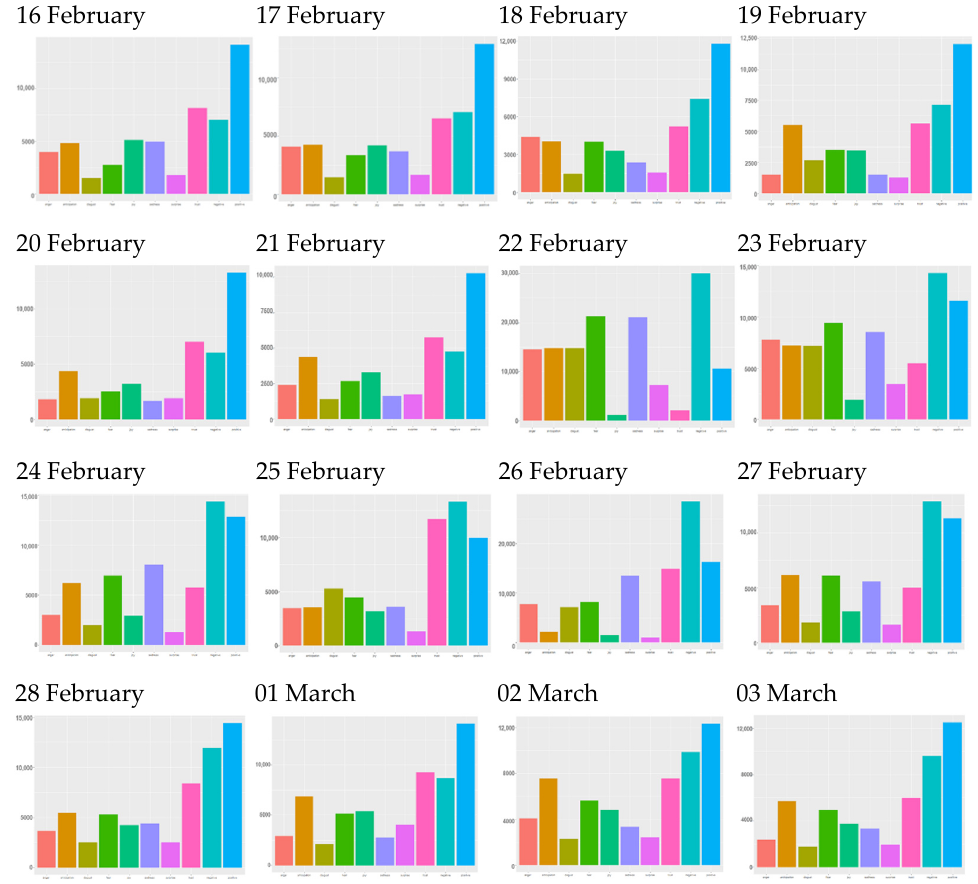
Figure 10. Daily sentiments and